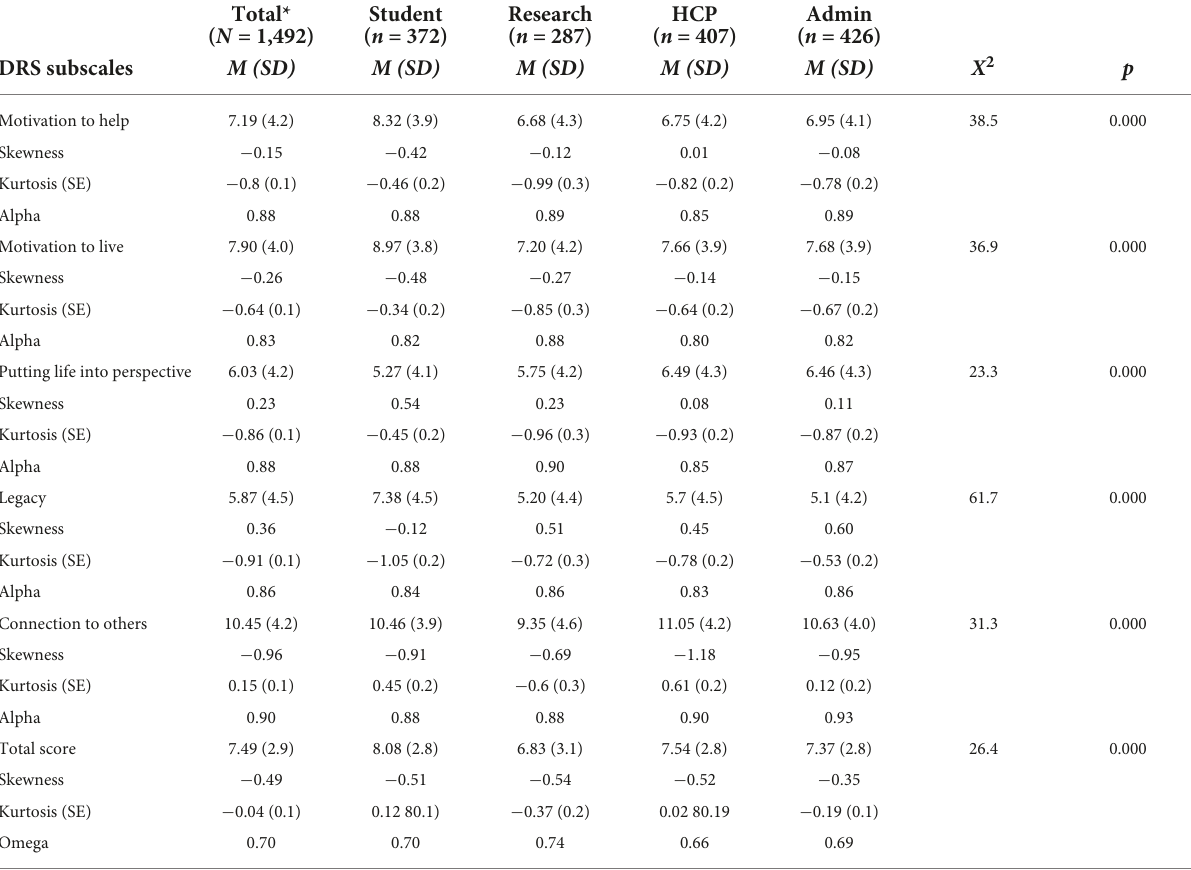
TABLE 3 The Death Reflection Scale items and scale descriptives in different occupational groups.